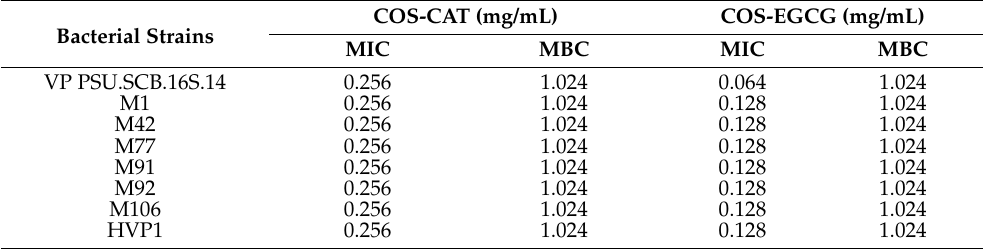
Table 3. Minimum inhibitory concentration (MIC) and minimum bactericidal concentration (MBC) of COS-tea polyphenol conjugates against eight isolates of V. parahaemolyticus . COS-CAT (mg/mL) Bacterial Strains